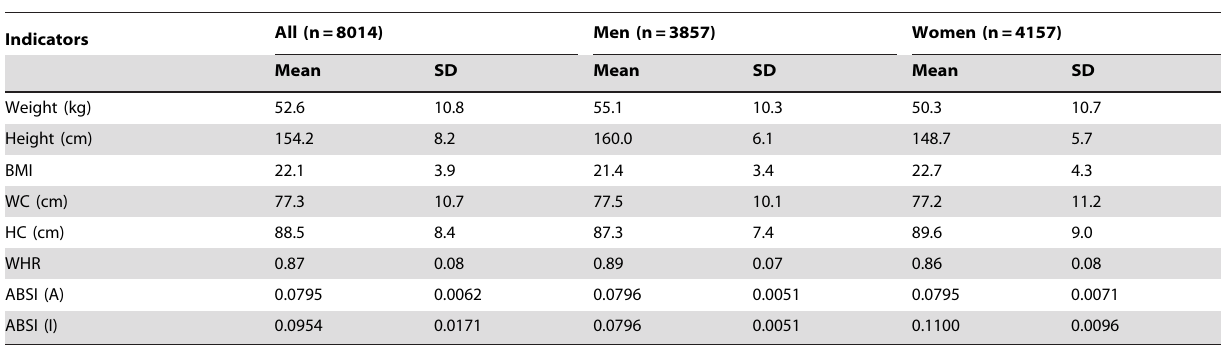
Table 1. Descriptive summary of the participants in 2000.